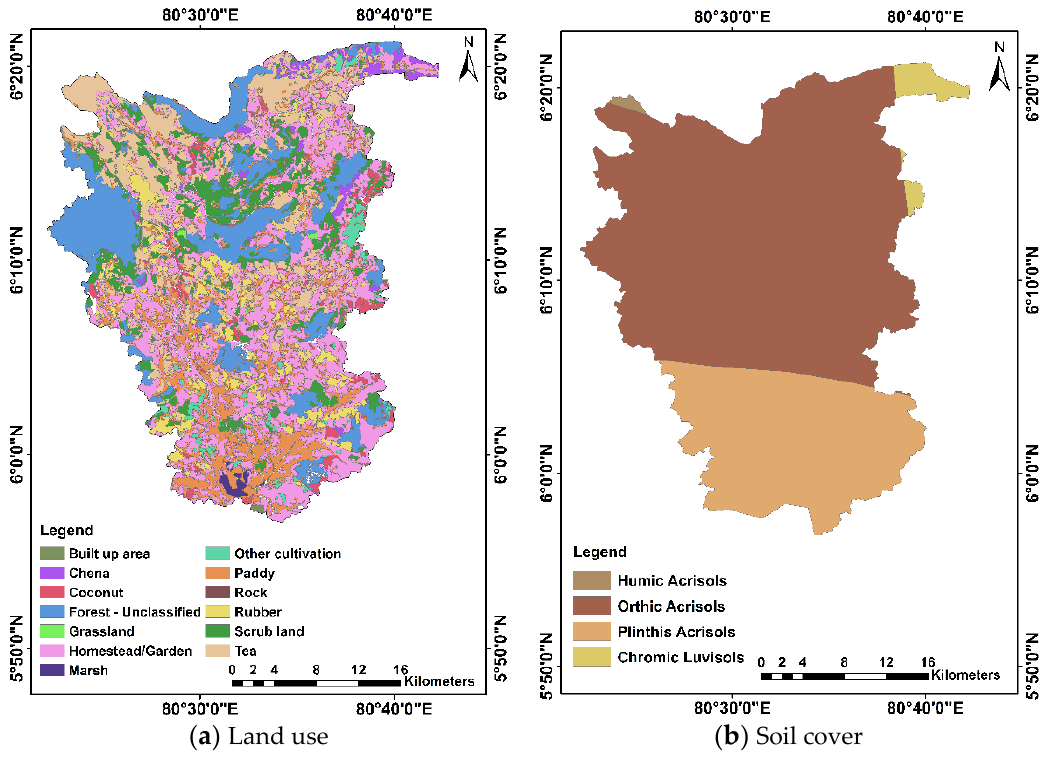
Figure 2. ( a ) Land use and ( b ) Soil maps of the Nilwala River Basin, Sri Lanka.